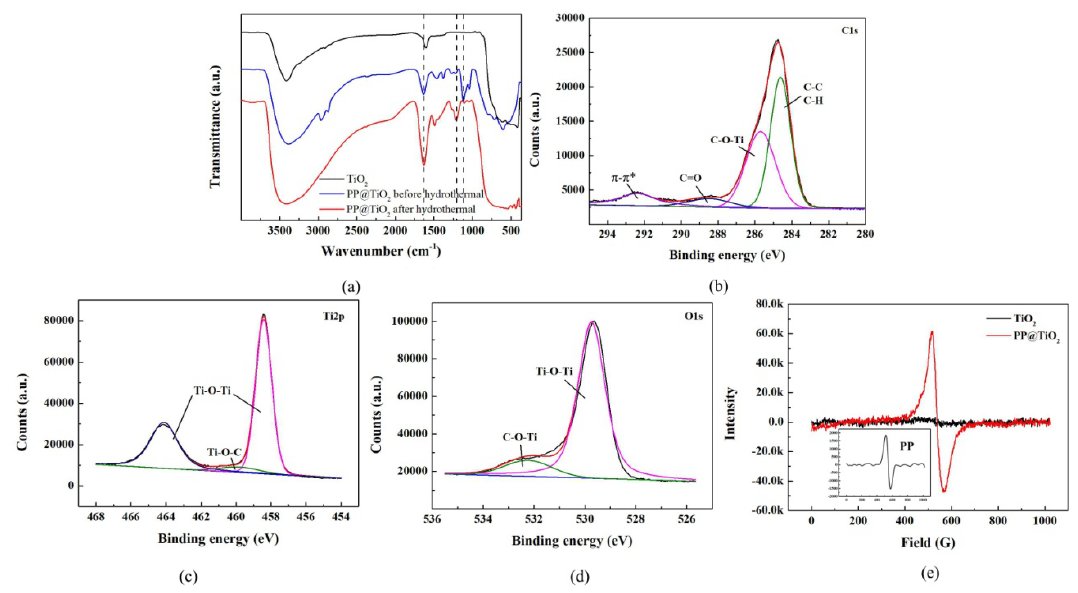
Figure 6. ( a ) Fourier-transform infrared (FT-IR) spectra of pure TiO 2 and PP@TiO 2 ; X-ray photoelectron spectroscopy (XPS) spectra of ( b ) C 1s , ( c ) Ti 2p , and ( d ) O 1s ; ( e ) electron paramagnetic resonance (EPR) spectrum of PP@TiO 2 nanosphere.